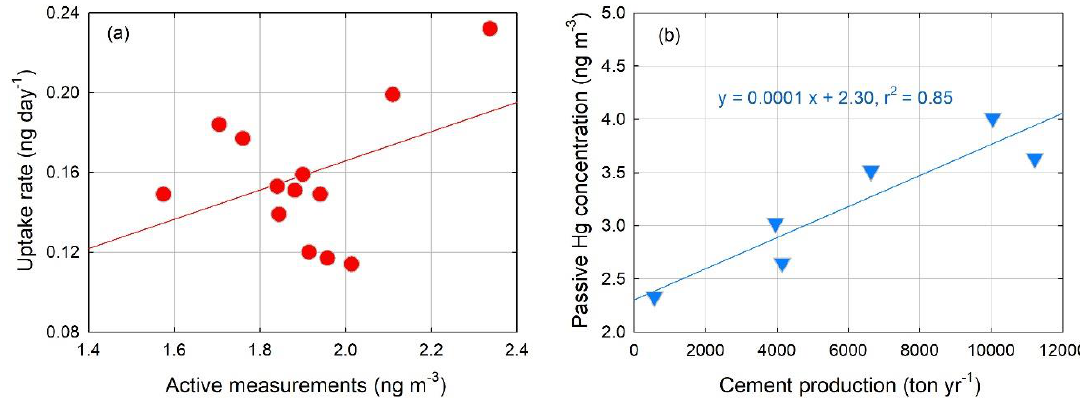
Figure 10. ( a ) Correlation between the uptake rate by the passive sampler and the Hg concentration by an active sampler (Tekran 2537X). ( b ) Relationship between the passive Hg concentration and cement production amount at six locations near the cement